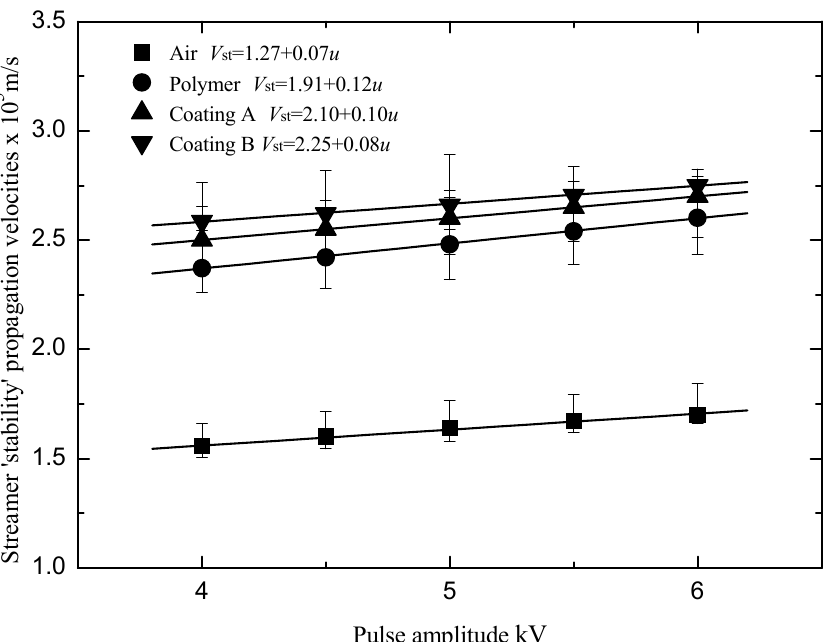
Figure 7. Relationship between the streamer ‘stability’ propagation velocities and the pulse amplitudes. The ‘surface’ and ‘air’ components of the streamers occurred when the applied elec- tric fields were larger than the streamer ‘stability’ propagation fields. The velocities of the ‘surface’ and ‘slow’ components under the varied electric fields are displayed in Figures 8 and 9, respectively. Equation (4) was used to draw the fitting curves in Figures 8 and 9. E st and V st come from Equations (2) and (3), and n and γ are the un- determined coefficients listed in Table 1.